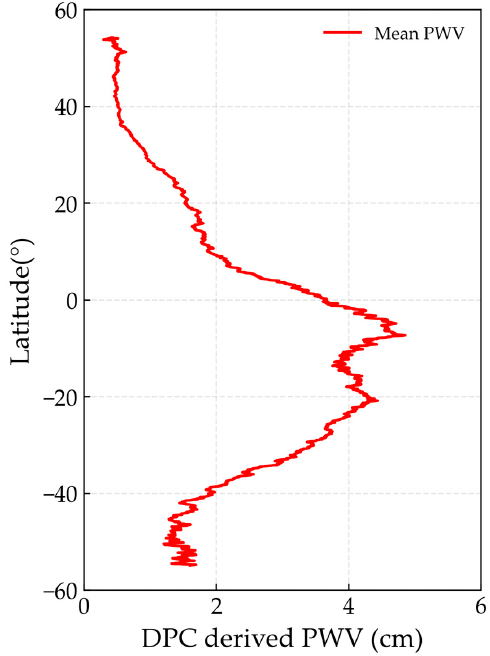
Figure 4. The 10-day zonally averaged PWV values observed using the Figure 4. The 10 ‐ day zonally averaged PWV values observed using the DPC.